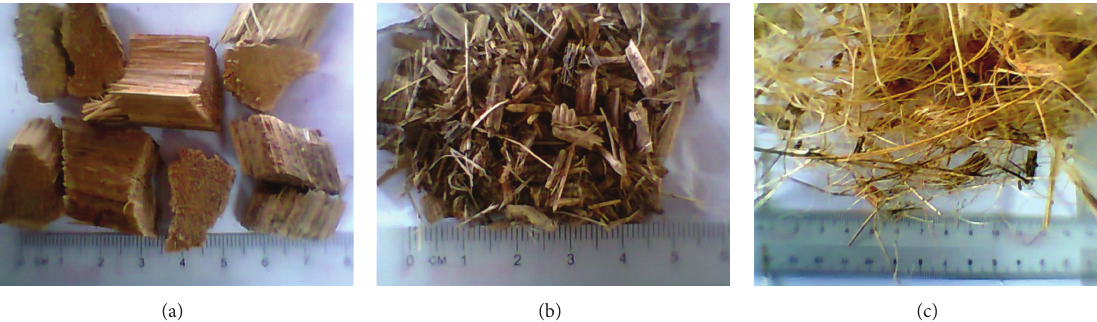
Figure 2: OPF feedstock particle sizes resulting from chipping (a) blocks 20 mm × 20 mm × 20 mm, (b) small particles of size less than 10mm, (c) fine